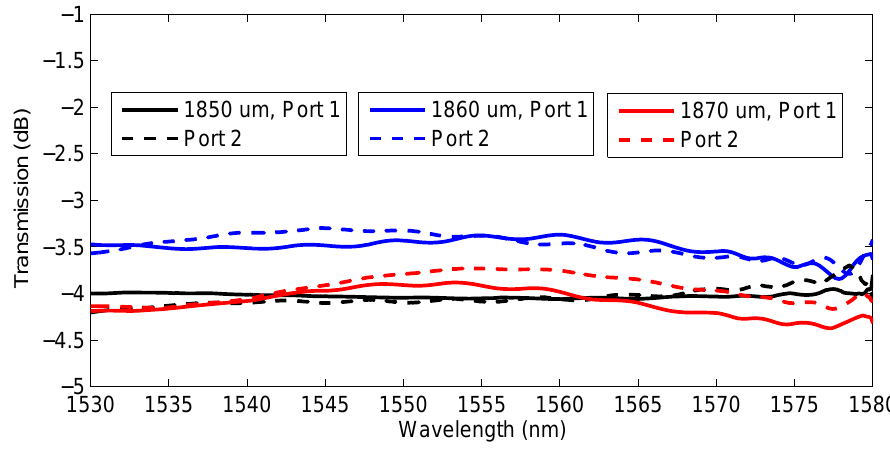
Figure 10. Normalized output transmission response at the two output ports of the MMI